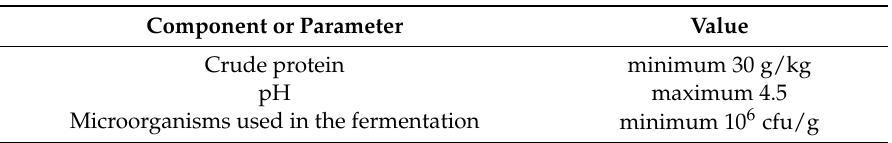
Figure 8. The Australian food guide.